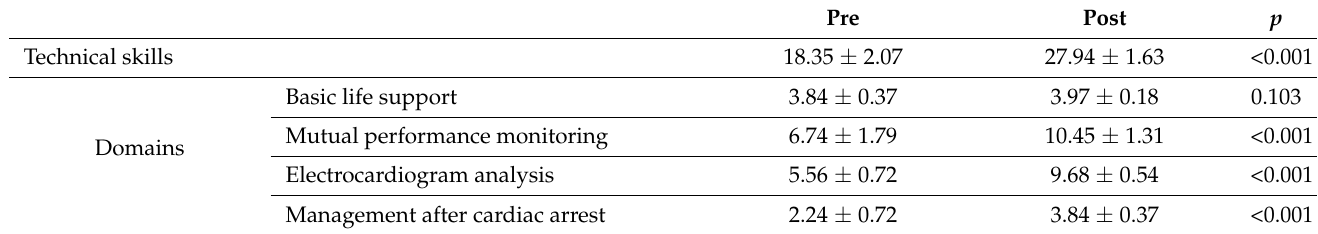
Table 5. Technical skill performance before and after Korean Advanced Life Support training ( n = 46).